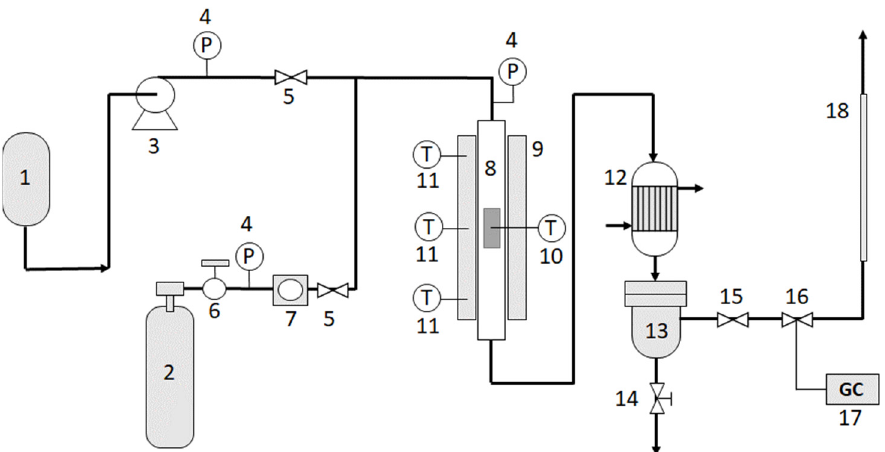
Figure 10. 1—Ethyl acetate reservoir; 2—Hydrogen bottle; 3—Pump; 4—Pressure gauge; 5—Valves;